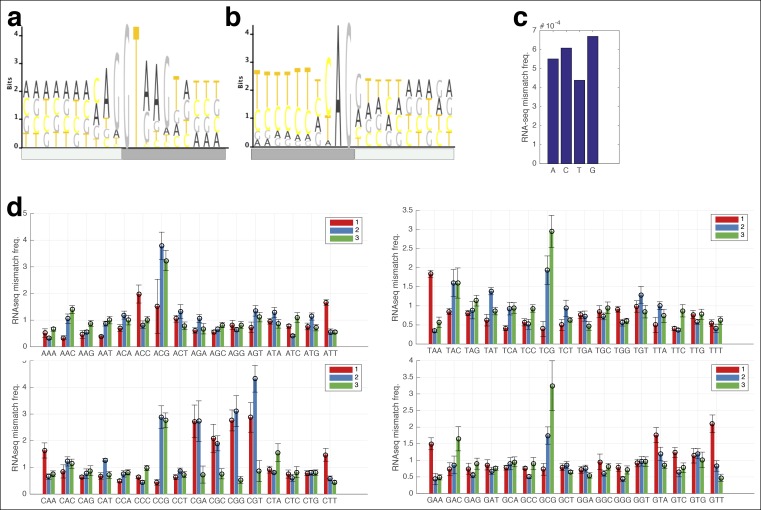
RNA-seq mismatch rates for all trinucleotides in chromatin-associated and nuclear RNAs.(a,b) The 5’ and 3’ splicing motifs in the human genome. (c) The RNA-seq mismatch frequencies for all single nucleotides. (d) The RNA-seq mismatch rate to the reference genome for each trinucleotide, normalized to the average mismatch rate across all trinucleotides. For each trinucleotide, red shows the mismatch frequency at the first base, blue at the second, and green at the third. Error bars are standard deviation across all samples.